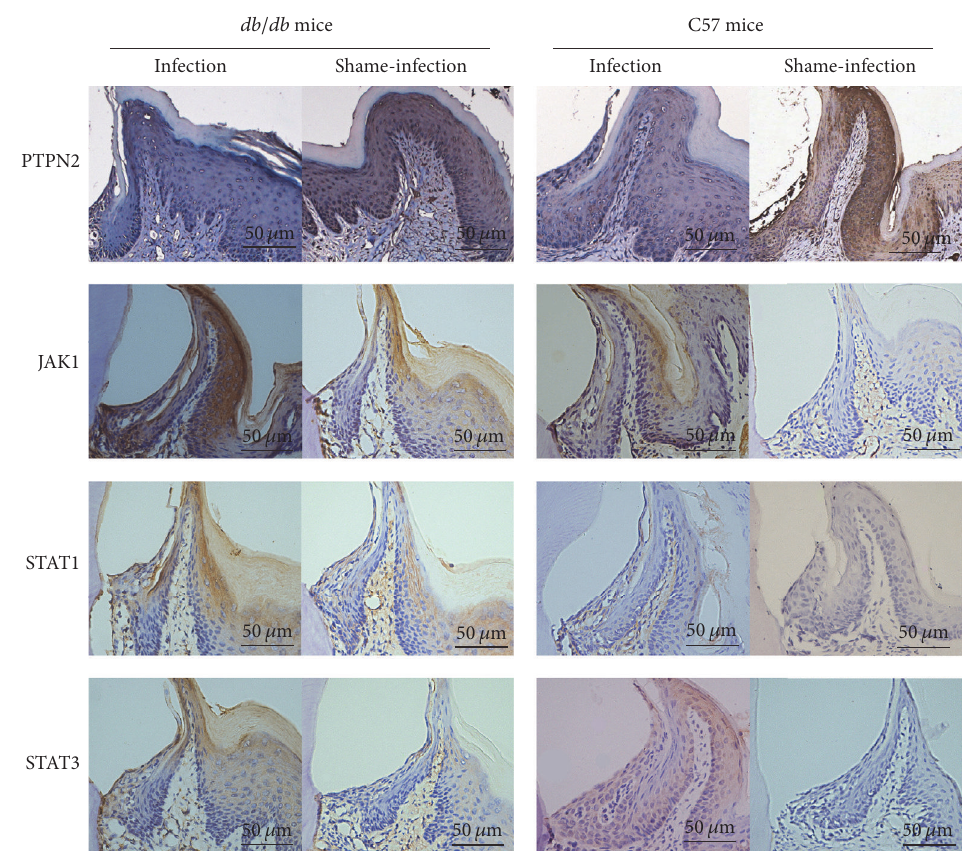
Figure 5: Protein expression of PTPN2, JAK1, STAT1, and STAT3 in the gingival epithelium of db/db and C57 mice was shown in the IHC stainingimages. AttenuatedexpressionofPTPN2andelevatedexpressionofJAK1,STAT1,andSTAT3wereseenininfectiongroupscompared to shame-infection groups in both db/db and C57